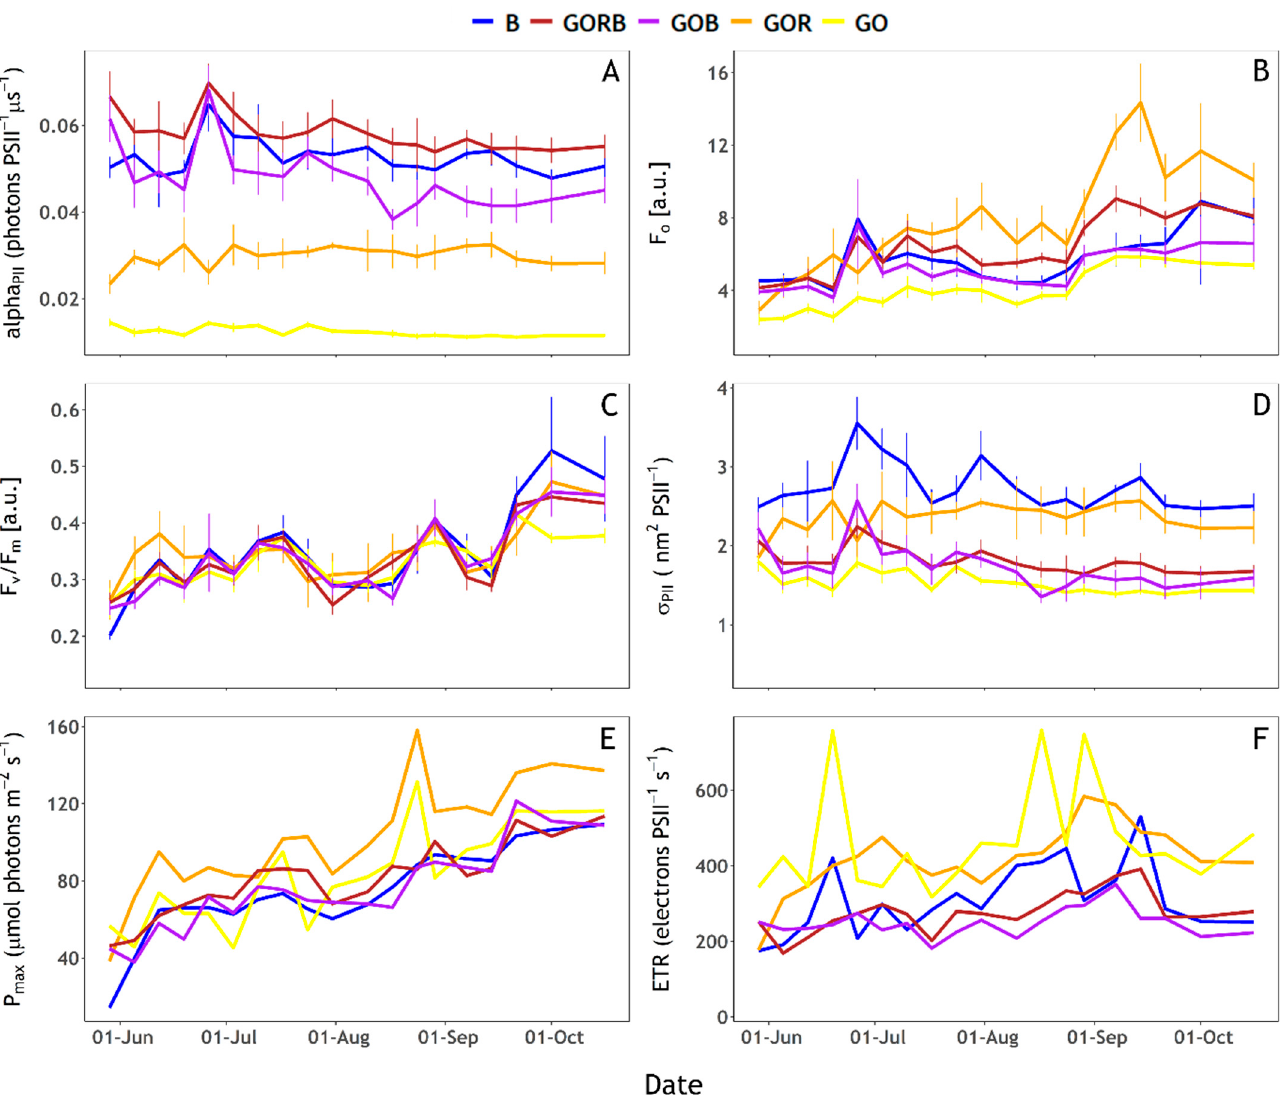
Figure 7. Fluorescence Light Curves ( FLCs) photosynthetic parameters obtained with the five excitation protocols (B), GORB, GOB, GOR and GO, see Table 1). ( A ) alpha PII (photons PSII − 1 µs − 1 ), ( B ) F o [a.u.], ( C ) F v /F m [a.u.], ( D ) σ PII (nm 2 PSII − 1 ), ( E ) P max (µmol photons m − 2 s − 1 ) and ( F ) ETR (electrons PSII − 1 s − 1 ).